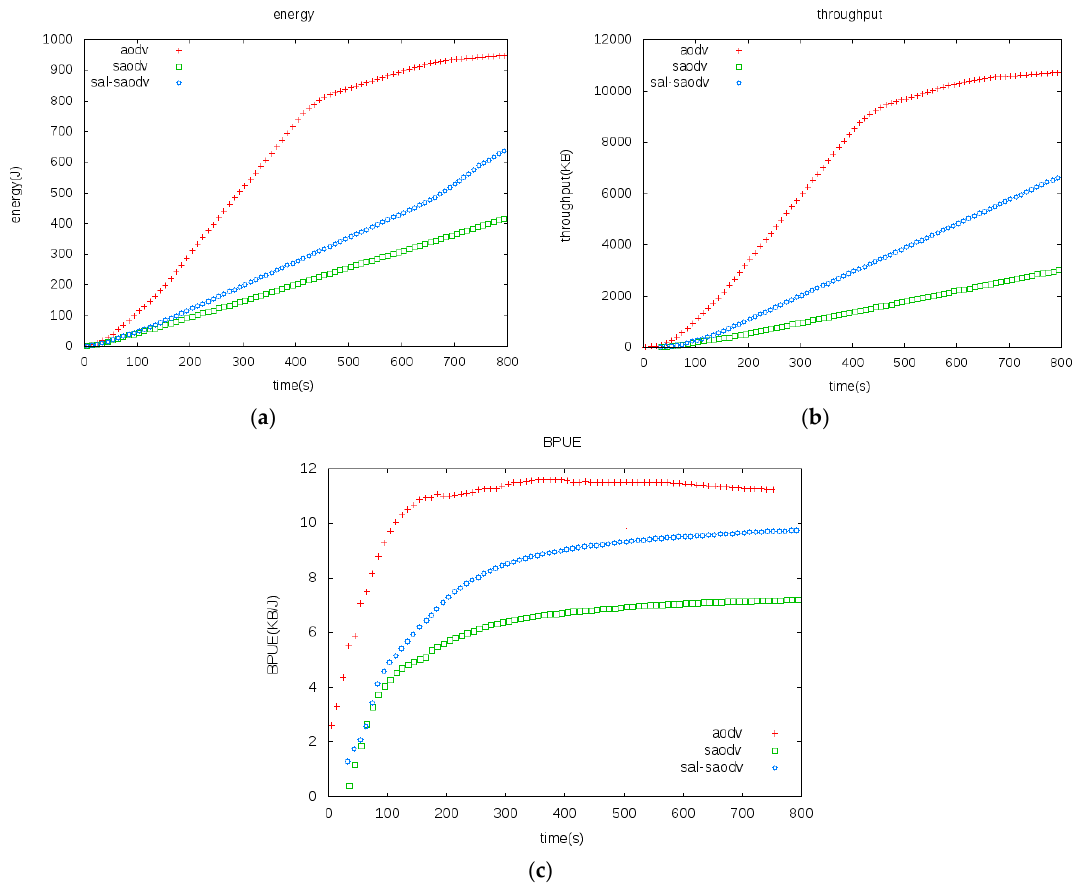
Figure 5. ( a ) Energy Consumption Comparisons, ( b ) throughput comparisons, ( c ) BPUE comparisons.